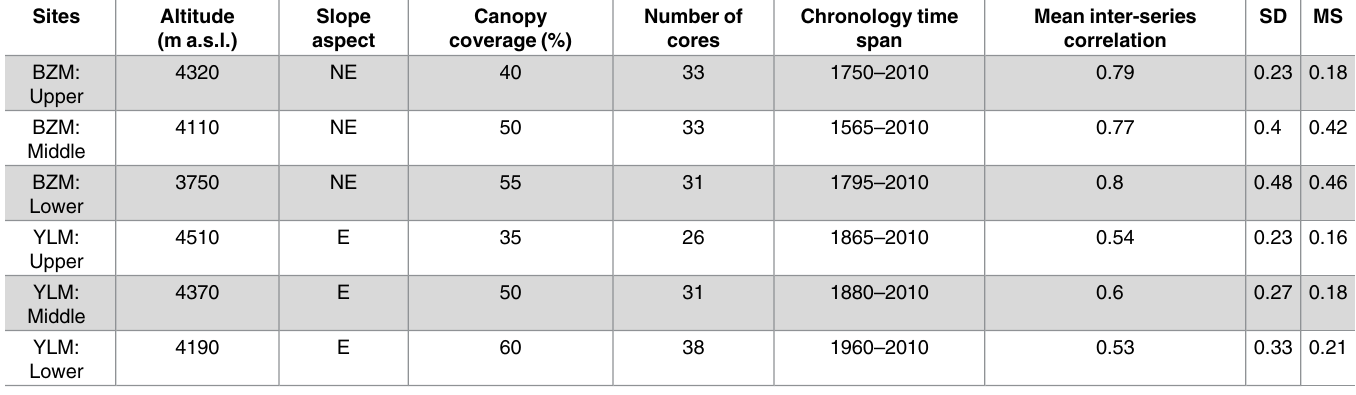
Table 1. Information of the study sites and ring-width series of Picea likiangensis var . balfouriana (Rehd. et Wils.) Hillier ex Slsvin. Sites Altitude Slope Canopy Number of Chronology time Mean inter-series SD MS (m a.s.l.) aspect coverage (%) cores span correlation BZM: NE 40 33 1750–2010 0.23 Upper